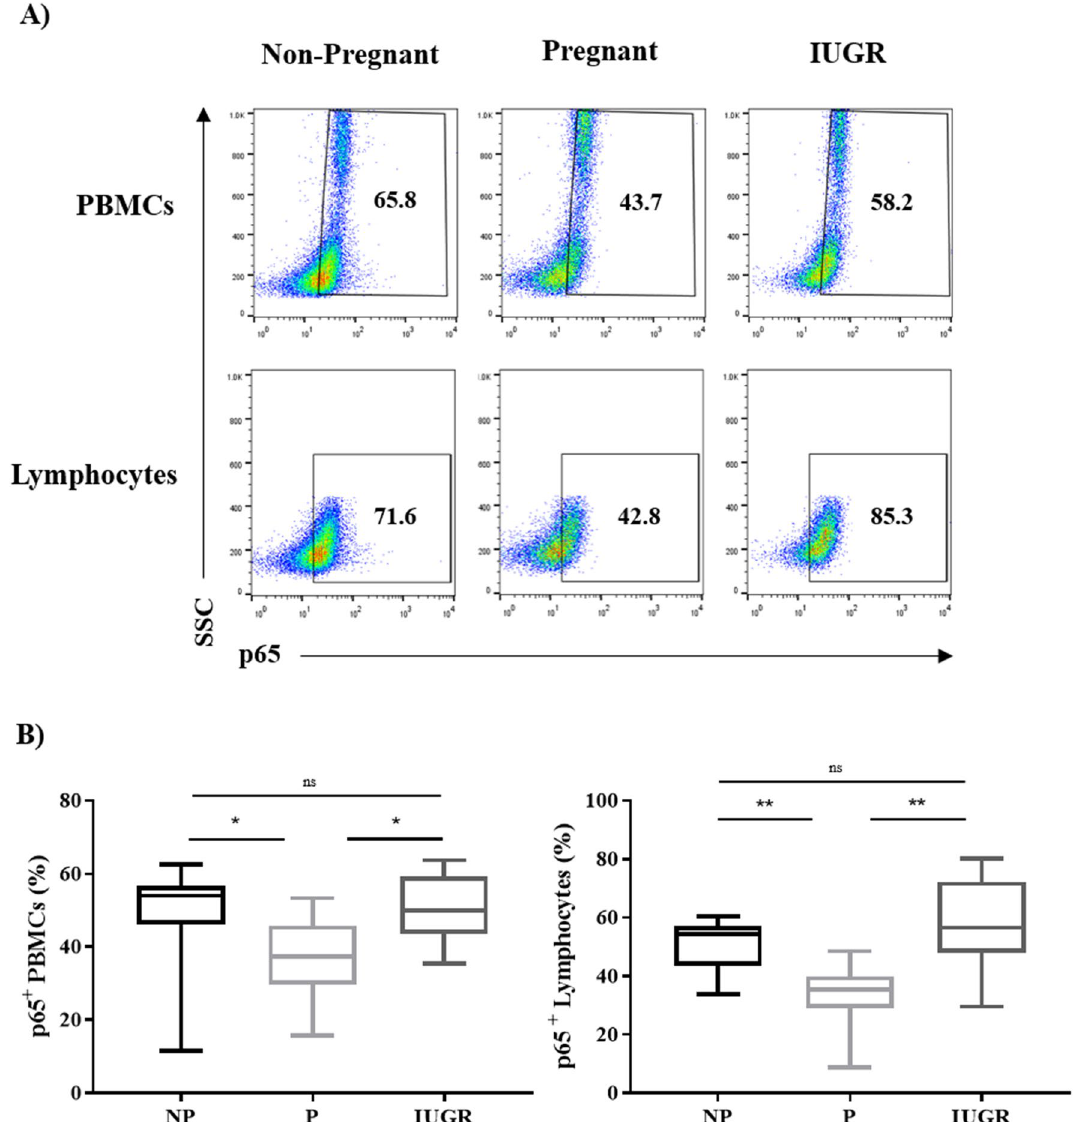
Figure 3. Expression of p65 in PBMCs and lymphocytes is reduced during normal pregnancy and increased during IUGR. ( A ) Representative flow cytometry dot plots of PBMCs and lymphocytes expressing p65 from NP (n = 11), P (n = 12) and IUGR women (n = 8). ( B ) Box and whisker plots indicate median and IQR of percentage of PBMCs and lymphocytes expressing p65. * p < 0.05, ** p < 0.01, ns = non-significant, determined by Kruskal– Wallis with Dunn’s multiple comparisons test. Flow cytometry data were analysed using the FlowJo Software Version 10 (Becton Dickinson); website: https:// www. flowjo.